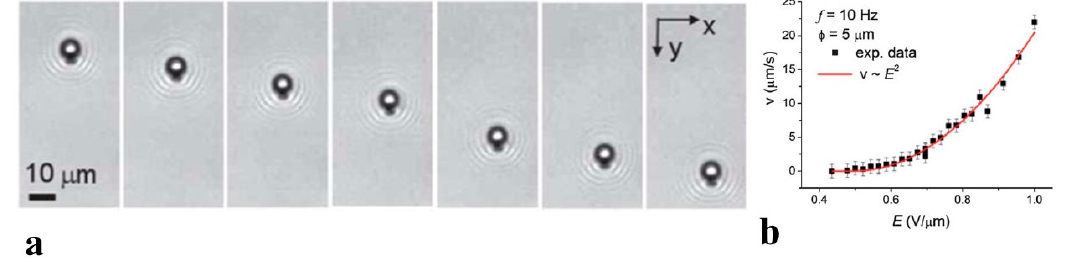
Figure 4. LCEP of water droplets driven by an AC electric field, as demonstrated by Hernàndez-Navarro et al. [37]. ( a ) Time sequence of optical microscopy of textures of a droplet with dipolar director field and a hyperbolic hedgehog; ( b ) Quadratic dependence of droplet velocity on the amplitude of the AC electric field. Adapted with permission from [37].